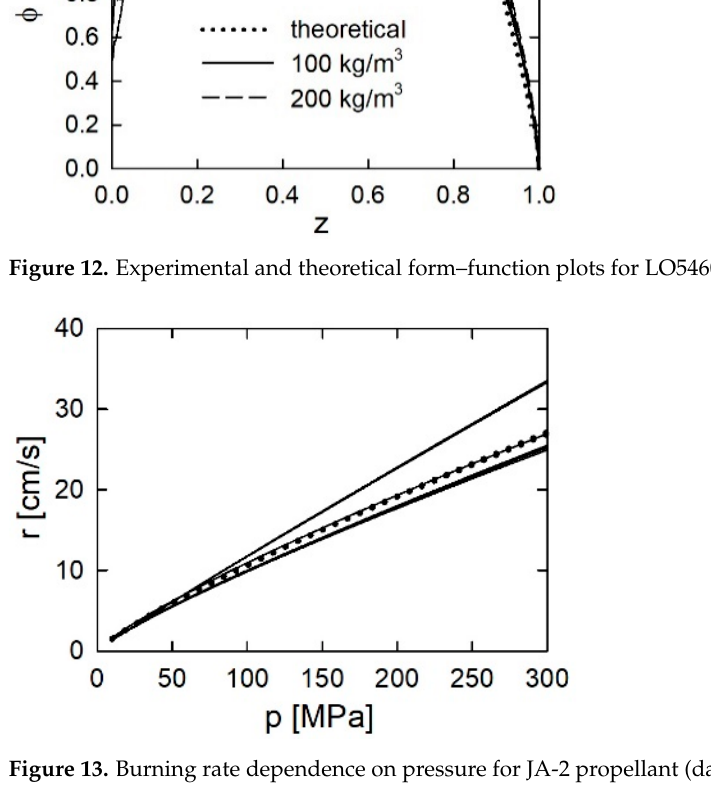
Energies 2022 , 15 , x FOR PEER REVIEW